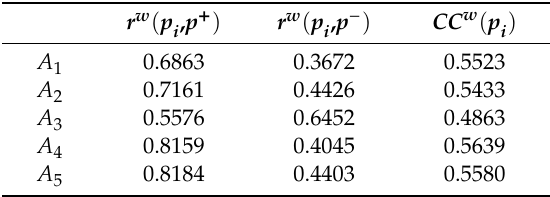
Table 3. Results rendered by the correlation-based technique for order preference by similarity to ideal solutions (TOPSIS) based on Singh’s correlation coe ffi